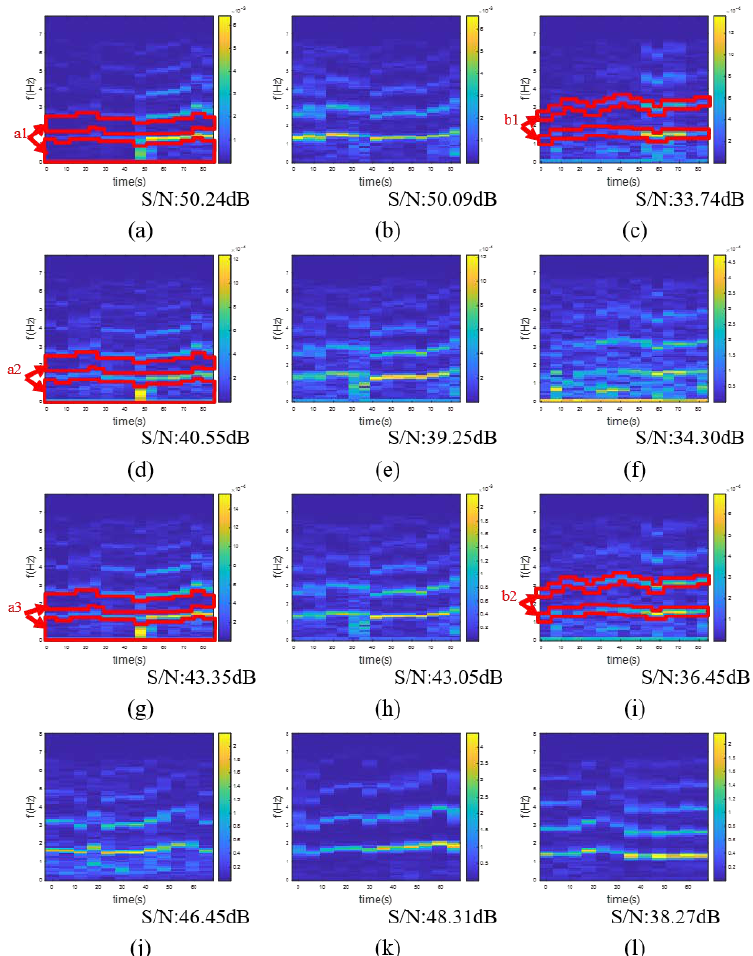
Figure 11. Short-time Fourier transform (STFT) of PPG signals in different postures and devices: ( a ) Green PPG of AFE4404EVM in hands down posture; ( b ) Green PPG of AFE4404EVM in hands forward posture; ( c ) Green PPG of AFE4404EVM in hands up posture; ( d ) Red PPG of AFE4404EVM in hands down posture; ( e ) Red PPG of AFE4404EVM in hands forward posture; ( f ) Red PPG of AFE4404EVM in hands up posture; ( g ) NIR PPG of AFE4404EVM in hands down posture; ( h ) NIR PPG of AFE4404EVM in hands forward posture; ( i ) NIR PPG of AFE4404EVM in hands up posture; ( j ) The proposed AW-PPG device in hands down posture; ( k ) The proposed AW-PPG device in hands forward posture; ( l ) The proposed AW-PPG device in hands up posture.